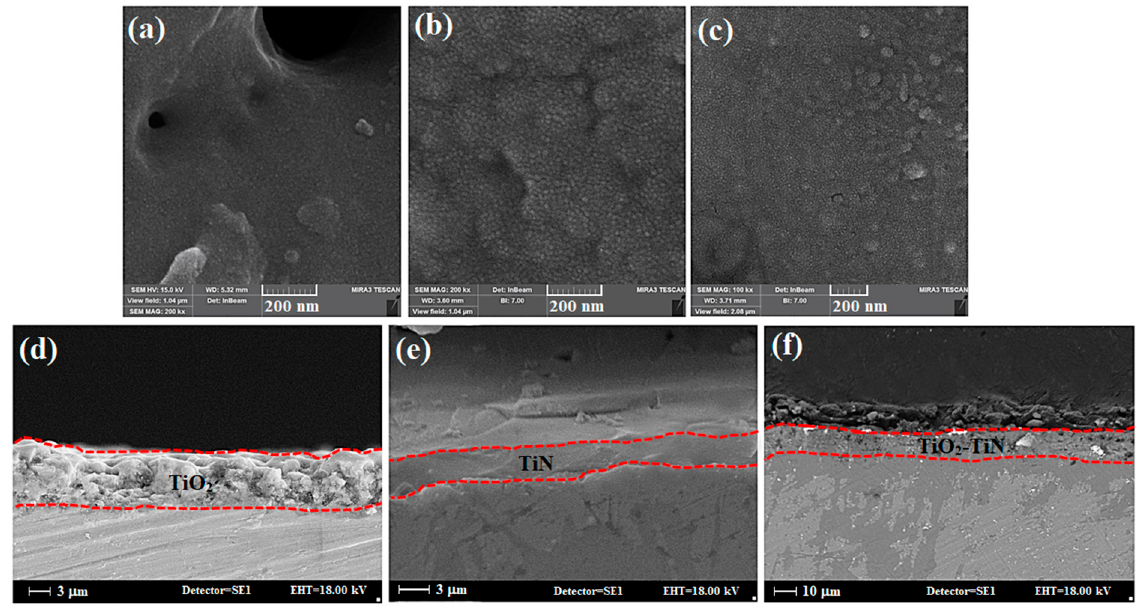
Figure 4. FE-SEM images of the surface morphology and cross-sectional images of the coated samples. ( a , d ) Ti/TiO 2 , ( b , e ) Ti/TiN, and ( c , f ) Ti/TiO 2 -N.